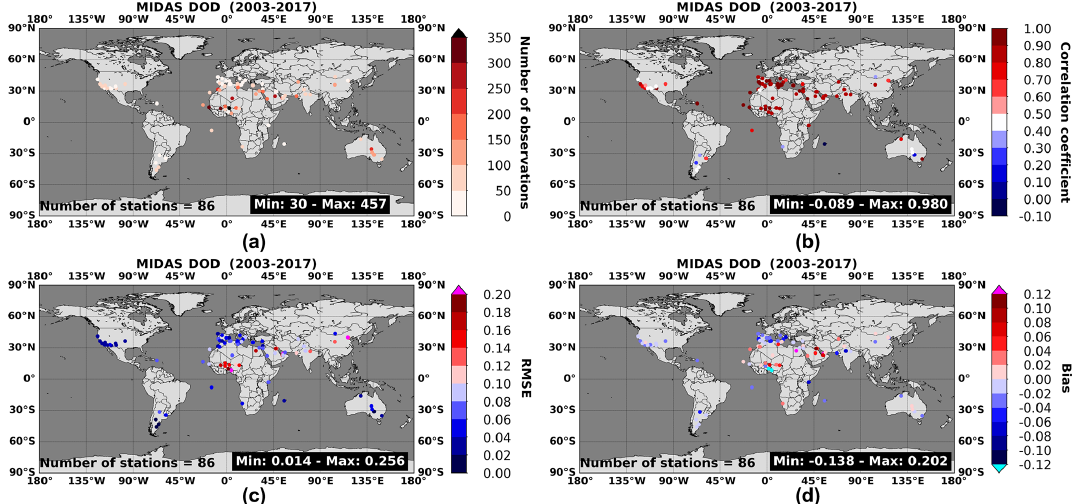
Figure 4. Scatterplot metrics between MIDAS and AERONET DOD 550nm , at station level, during the period 2003–2017. (a) Number of concurrent MIDAS–AERONET observations, (b) correlation coefficient, (c) root mean square error, and (d) bias defined as spaceborne minus ground-based retrievals. The obtained scores are presented only for sites with at least 30 MIDAS–AERONET